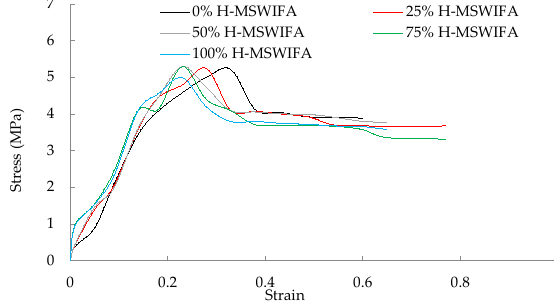
Figure 8. FSFE curve of asphalt mastic at F/A of 0.8.